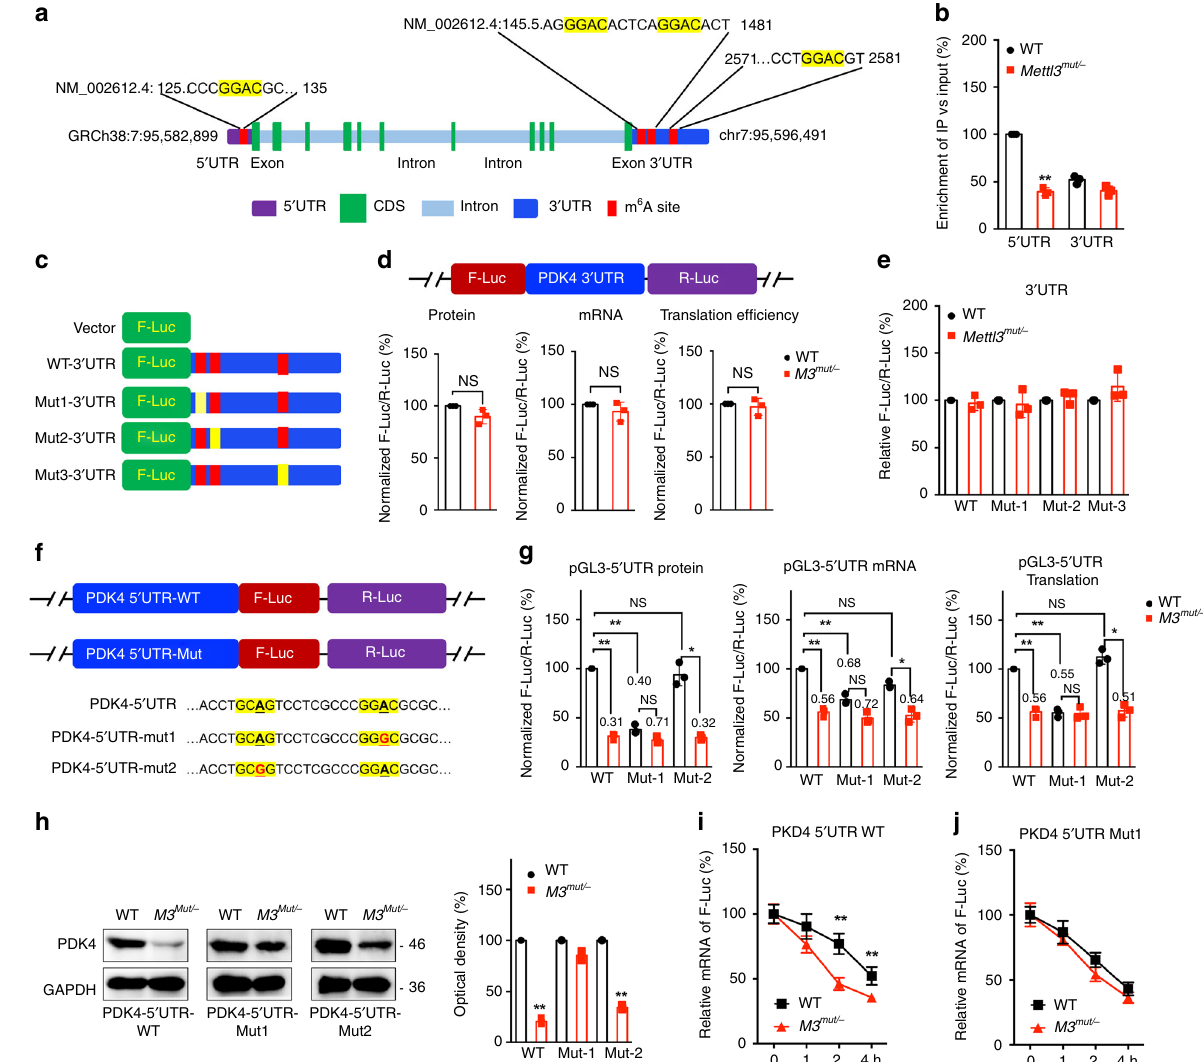
Fig. 4 Methylation sites of PDK4 involved in m 6 A regulated expression of PDK4. a Schematic representation of positions of m 6 A motifs within PDK4 mRNA. b The m 6 A in 5 ′ UTR or 3 ′ UTR of PDK4 in wild type or Mettl3 Mut/- HeLa cells were analyzed by m 6 A-RIP-qPCR using fragmented RNA. c Schematic representation of mutated (GGAC to GGCC) 3 ′ UTR of pmirGLO vector to investigate the roles of m 6 A in 3 ′ UTR in PDK4 expression. d Wild-type or Mettl3 Mut/- HeLa cells were transfected with pmirGLO-PDK4-3 ′ UTR-WT reporter for 24 h. The protein, mRNA and translation ef fi ciency were determined. e The relative luciferase activity of F-Luc/R-Luc of pmirGLO-3 ′ UTR-WT, or pmirGLO-3 ′ UTR-Mut-1/-2/-3 in wild type and Mettl3 Mut/- HeLa cells; f Schematic representation of mutation in 5 ′ UTR to investigate the m 6 A roles on PDK4 expression. g Wild-type or Mettl3 Mut/- HeLa cells were transfected with pGL3-PDK4-5 ′ UTR-WT or pGL3-PDK4-5 ′ UTR-Mut1/2 reporter for 24 h. The protein, mRNA and translation ef fi ciency were determined. h pcDNA- PDK4-5 ′ UTR-WT or pcDNA-PDK4-5 ′ UTR-Mut1/2 was transfected into wild type or Mettl3 Mut/- HeLa cells for 24 h. Protein expression was measured by western blot analysis (left) and quantitatively analyzed (right). i , j pcDNA-PDK4-5 ′ UTR-WT ( i ) or pcDNA-PDK4-5 ′ UTR-Mut1 ( j ) was transfected into